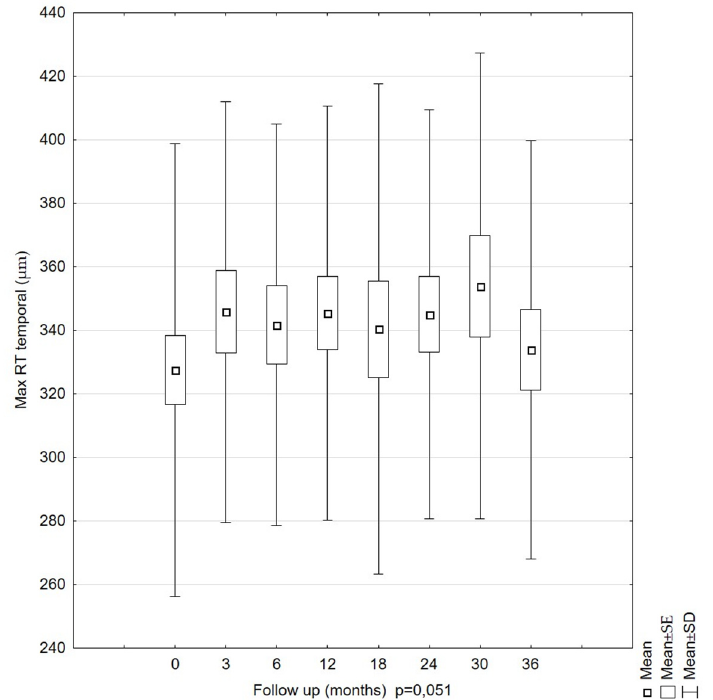
Figure 3. Average values of maximal retinal thickness (Max RT) for the temporal area of patients during the 36-month follow-up period. The Max RT temporal value showed no statistically significant changes over this period.